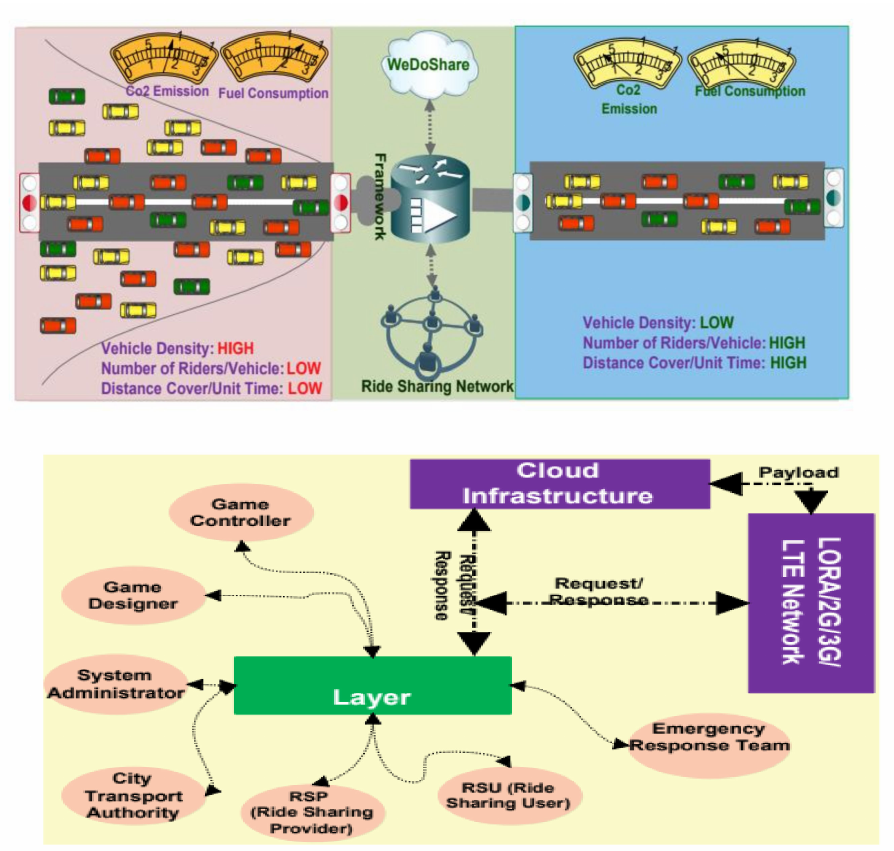
Figure 13. Ride sharing transportation architecture [35].